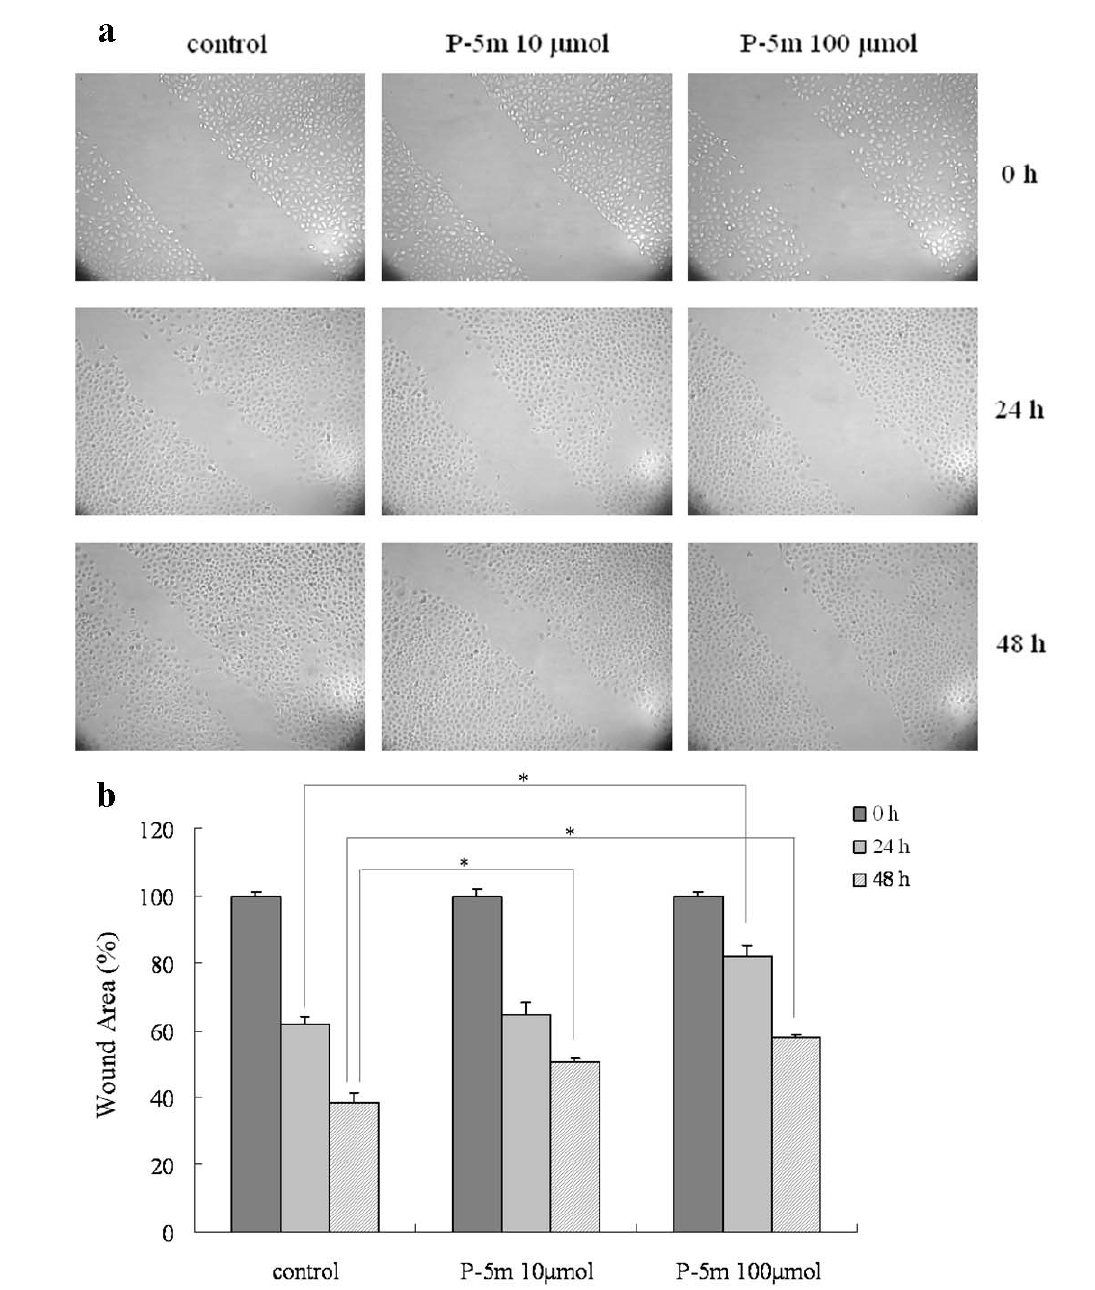
Figure 2. Effects of P-5m on migration in HCCLM3 cells. Cell migration was analyzed by wound healing assay. ( a ) Cells were cultured with P-5m (0, 10 and 100 μ mol) for 48 h. Photographs were taken 0, 24 and 48 h after a wound was generated. ( b ) Cell migration was analyzed by NIH Image software (Image J). The results were expressed as percentages of the mean of wound area at 0, 24 and 48 h. The quantitative data are presented as mean ± SD of three independent experiments. * P < 0.05, compared with the respective untreated